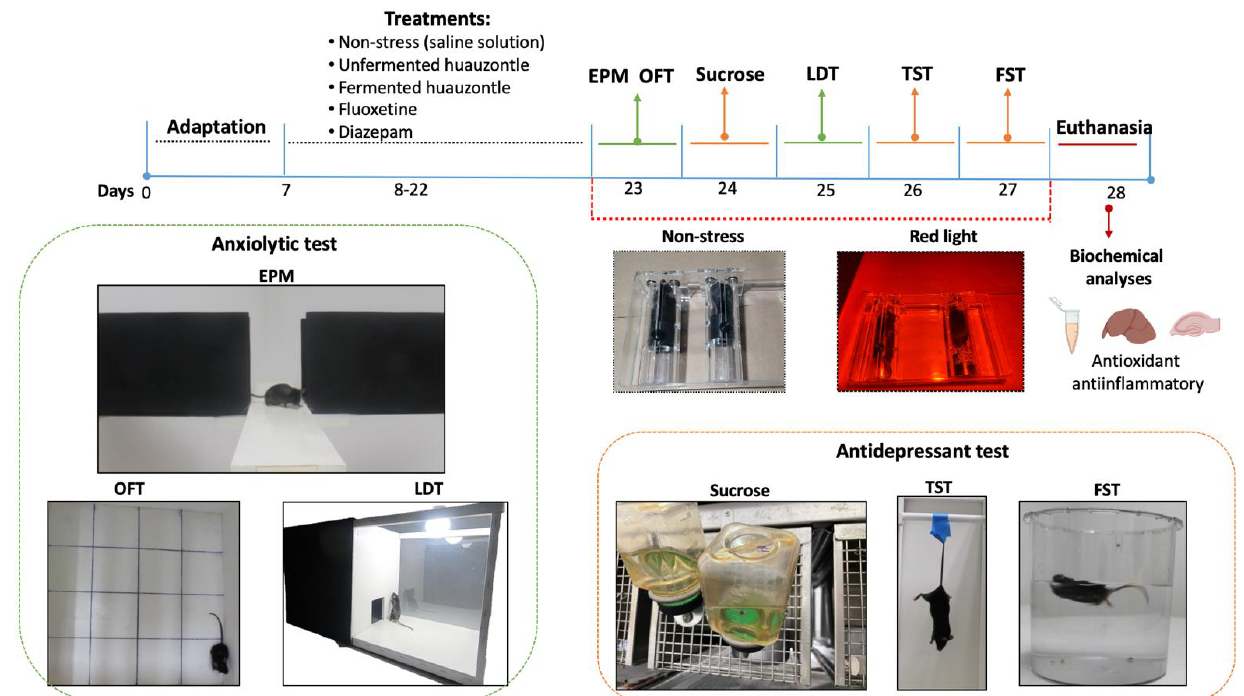
Figure 1. Schematic representations of the experimental protocol indicating the treatments and anxiety-like and depression-like tests. (Day 23) Elevated Plus Maze (EPM), Open Field Test (OFT), and sucrose preference test, (day 25) Dark/light exploratory box (LDT), (day 26) Tail suspension test (TST), (day 27) Forced swim test (FST). Day 28, mice were euthanized, via intraperitoneal injection with sodium pentobarbital (90 mg/kg body weight) and samples of blood, liver and hippocampus were collected for further analyses.